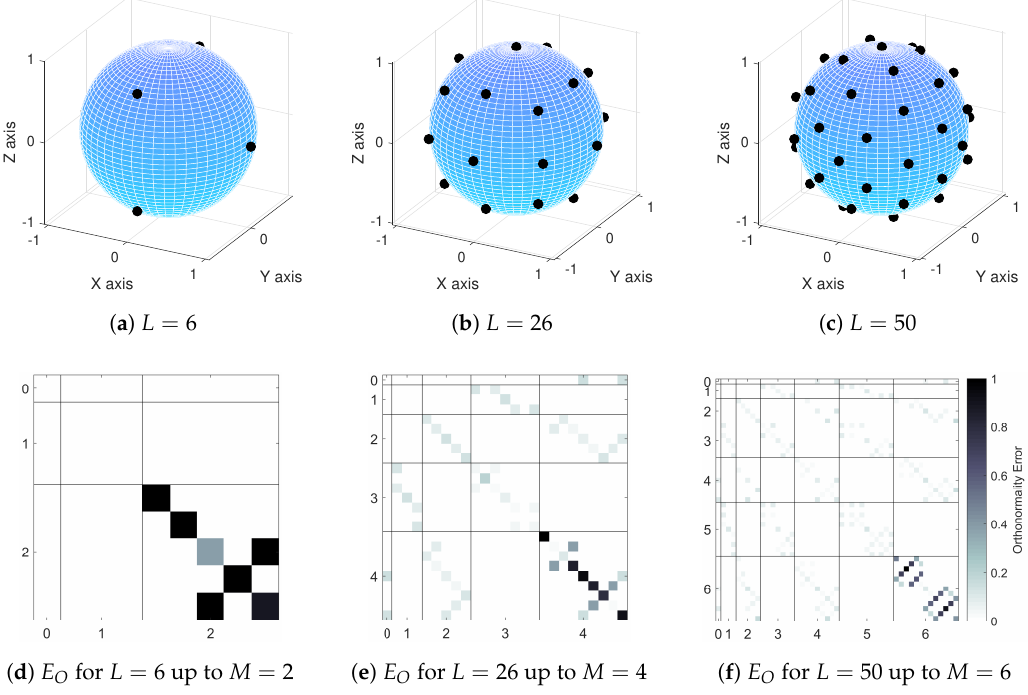
Figure 1. Loudspeaker layouts and orthonormality error matrices for the three Lebedev loudspeaker configurations used in this paper: ( a ) loudspeaker layout for M = 1 ( L = 6), ( b ) loudspeaker layout for M = 3 ( L = 26), ( c ) loudspeaker layout for M = 5 ( L = 50), ( d ) orthonormality error matrix plot for M = 1 ( L = 6), ( e ) orthonormality error matrix plot for M = 3 ( L = 26) and ( f ) orthonormality error matrix plot for M = 5 ( L = 50). In orthonormality error matrix plots, spherical harmonics of different orders are separated to aid visual